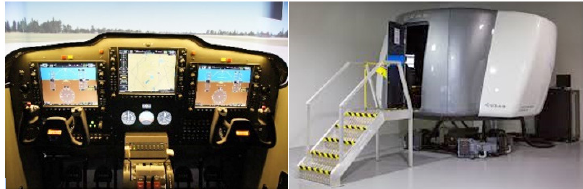
Figure 2. Research devices: (a) pulse